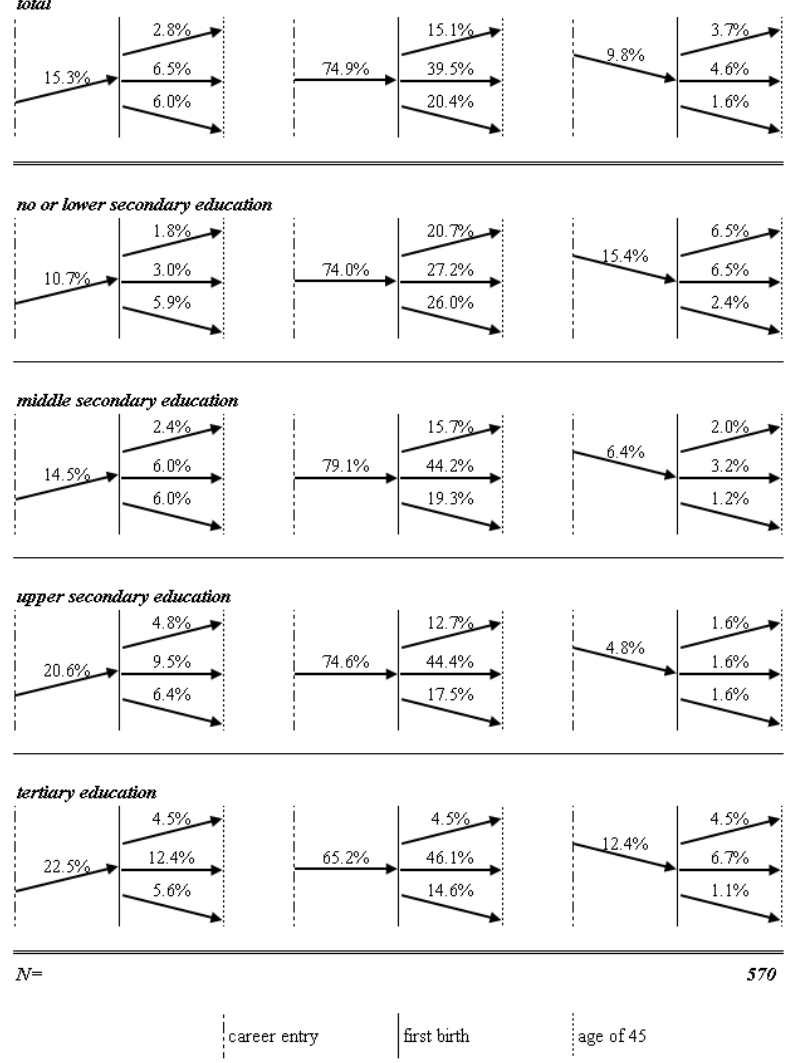
Figure 2 : development of occupational prestige before and after timing in total and by educational